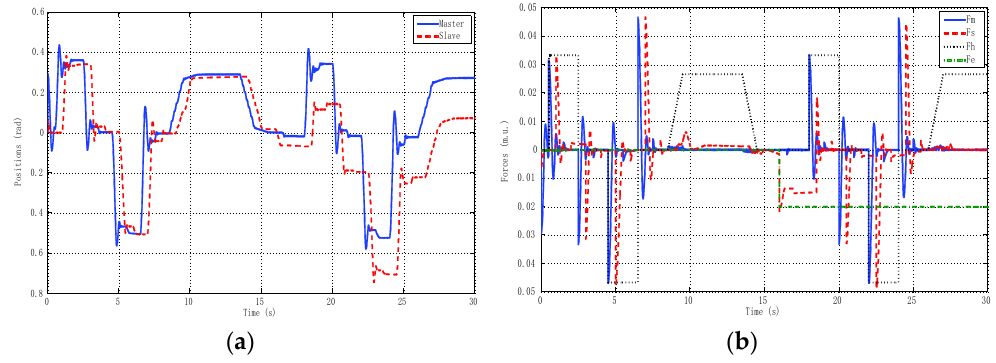
Figure 16. Local teleoperation using haptic devices with h max = 0.5 s and d = 0.45. ( a ) Positions; ( b ) Forces.